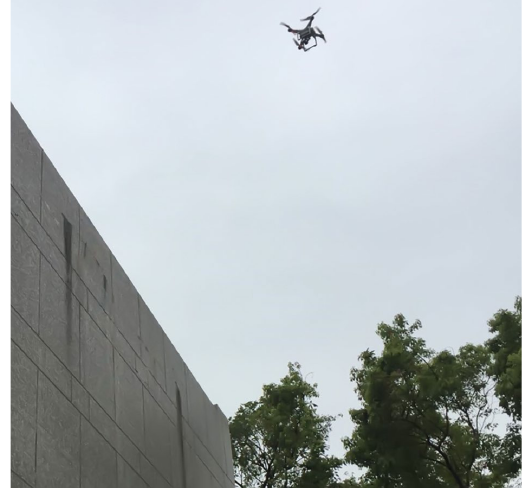
Figure 10. The real time sample picture captured by